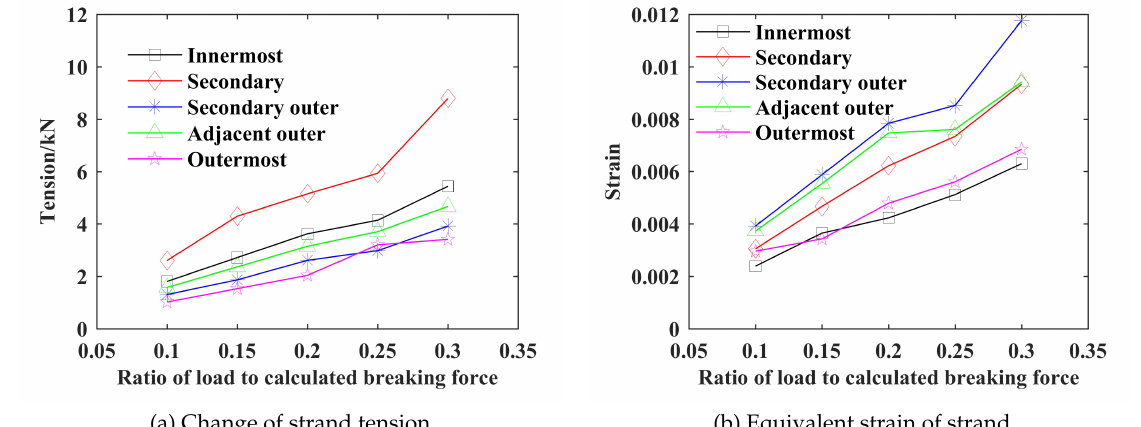
Fig. 10. Mechanical changes of different layers of stranded